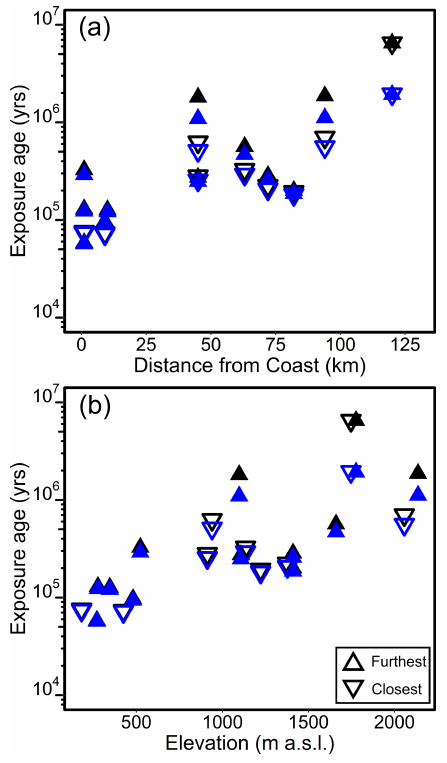
Figure 8. Inferred surface exposure durations versus distance from the coast (a) and elevation (b) , with (black) and without (blue) an as- sumed erosion term. Upward-facing triangles are samples collected furthest from the glacier, while downward triangles are samples col- lected closest to the